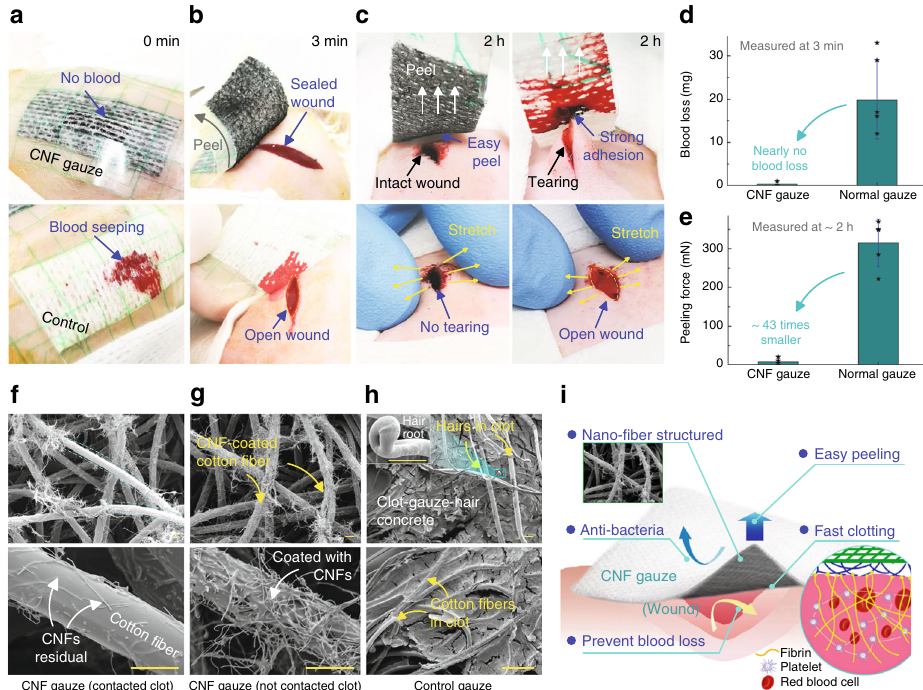
Fig. 5 In vivo animal experiment. a The plaster-like gauzes were patched onto incisions on rat back (Supplementary Fig. 16a-d); the control cotton gauze got wet quickly, while the CNF gauze prevented blood loss. b Peeling the gauze at 3 min to measure the blood loss; the CNF gauze helped form a gel-like clot, which properly sealed the wound; under the control gauze, an open wound was observed. c Peeling the gauze at about 2 h to measure the peeling force (Supplementary Fig. 16g-i); the CNF gauze could be easily peeled off and gently stretching the wound did not cause wound tearing or bleeding (Supplementary Movie 6); in contrast, peeling the normal gauze caused wound tearing and bleeding (Supplementary Movie 7). d The CNF gauze minimized blood loss ( n = 6). e Peeling force for the CNF gauze was signi fi cantly smaller than that for the normal gauze ( n = 5). f SEM images of the area in contact with blood on the CNF gauze in c ; CNF residuals after clot detachment were observed on cotton fi bers. g SEM images of the area not in contact with blood on the CNF gauze in c , where cotton fi bers were densely coated with CNFs. h SEM images of the peeled normal gauze in c , showing a clot- gauze-hair concrete, with rat skin hairs imbedded in clot; a hair root is shown in the inset, implying that skin hairs that were stuck in the clot were pulled out from skin during gauze peeling. i Schematic of the hemostatic CNF gauze/plaster for wound treatment. Data in d and e are shown as mean ± SD, the error bar represents SD, and individual data points in d and e are represented by black stars. Scale bars are 10 μ m in f , 15 μ m in g , and 100 μ m in h . Source data for d and e are provided as a Source Data fi